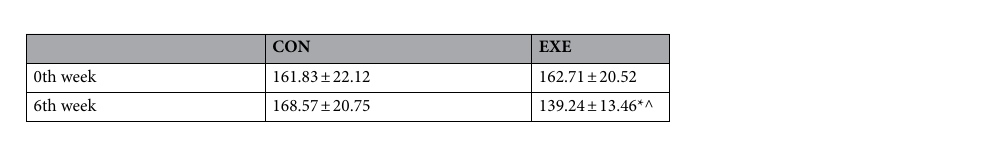
Table 3. SUA level of all rats before and after 6 weeks of intervention (μmol/L). *Significantly different from CON ( p < 0.05), ^Significantly different from 0th week ( p < 0.05).